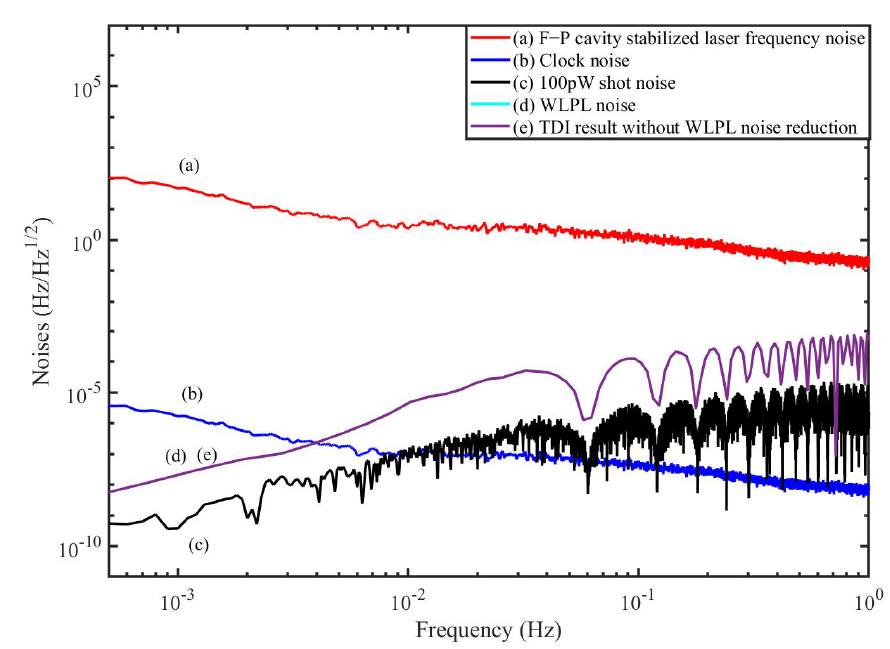
Figure 8. TDI results of the simulation without WLPL noise